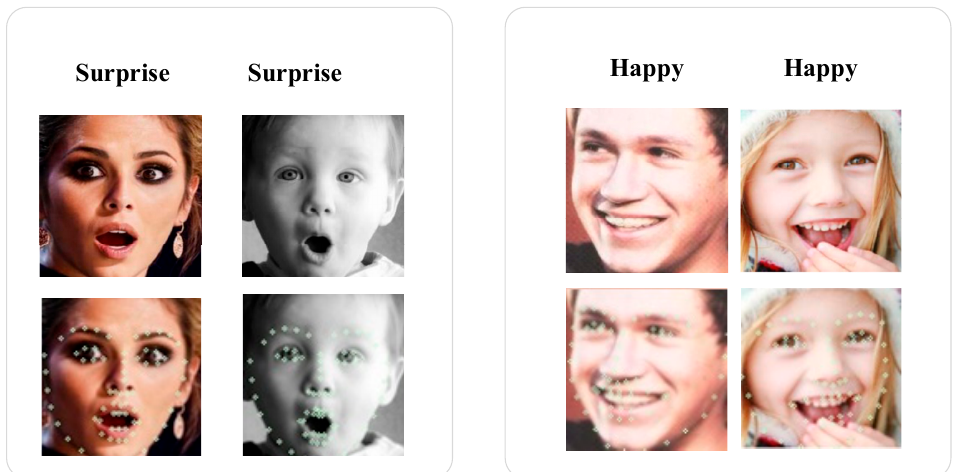
Figure 1. Intra-class differences are unrelated to expressions (the facial landmarks are detected by [44]). Images can have huge differences within the same expression class. For example, age and gender are different in different samples. As shown in the figure, the left and right images both represent the expressions of surprise and happiness, respectively, but they are visually very different. The above images are from AffectNet [7].